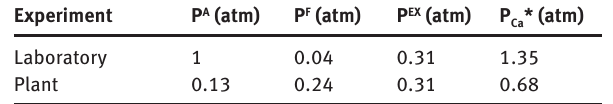
Table 4: Critical pressure P Ca * ( = P A + P F + P EX ) of calcium required for vaporization in molten steel.